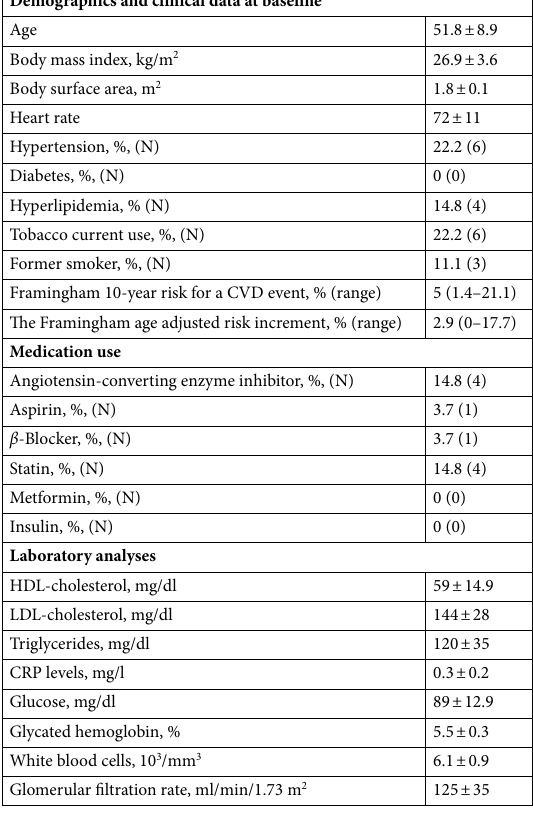
Table 1. General characteristics. Data are presented as mean ± SD, n (%) or median (range) when appropriated. CVD cardiovascular